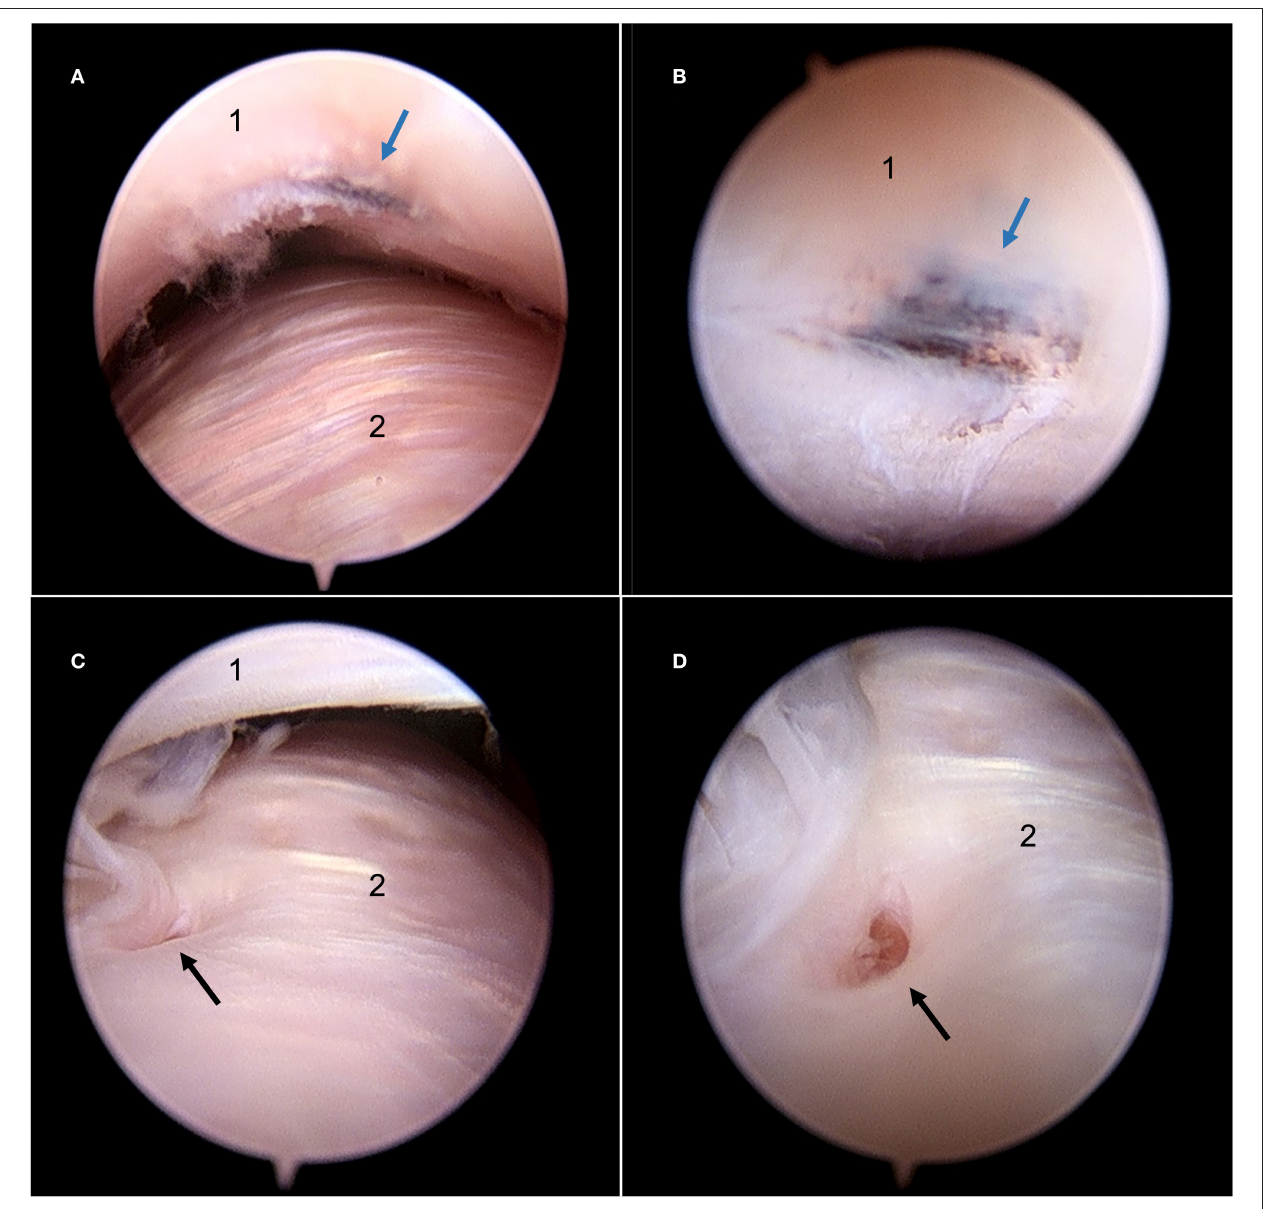
FIGURE 5 | Still arthroscopic image of the DMJ using the STAN illustrating two abnormalities identified with this system which were not identified during joint exploration using the NAS. (A) View of an abnormal discoloration on the ventral aspect of the intra-articular disc from a distance. (B) Advancing the arthroscope highlights the dark pigmentation (blue arrow) present on the ventral aspect of the intra-articular disc. (C) Caudal aspect of the condylar process of the mandible with a defect on the articular surface. (D) Advancing the arthroscope confirms the presence of a cloaca associated with a mandibular cyst (black arrow). 1, Intra-articular disc; 2, condylar process of the